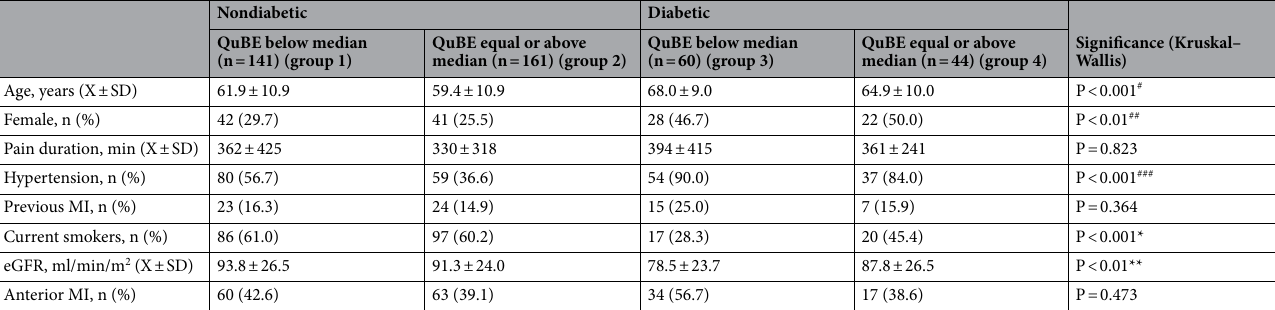
Table 1. Baseline characteristics of nondiabetic and diabetic patients, stratified by median QuBE value. QuBE quantitative myocardial blush evaluator, eGFR estimated glomerular filtration rate, MI myocardial infarction.